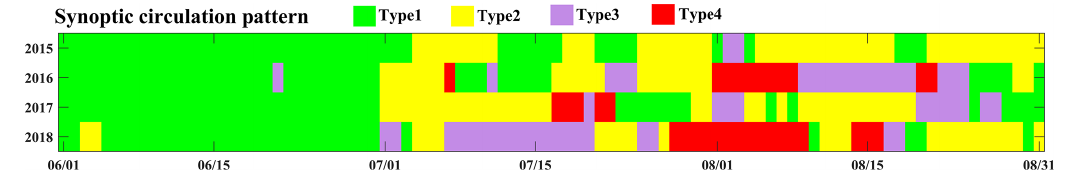
Figure 5. Time series of synoptic circulation